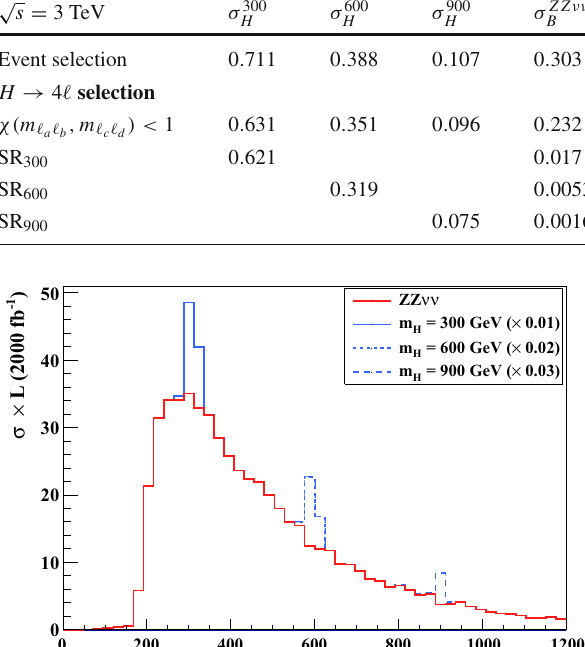
Table 1 3 TeV CLIC cross section (in fb) for signal (for m H = 300, 600, 900 GeV respectively) and the dominant SM background σ ZZ νν at different stages in the event selection and in the signal region (SR) for m H = 300, 600, 900 GeV respectively (see text for details) √